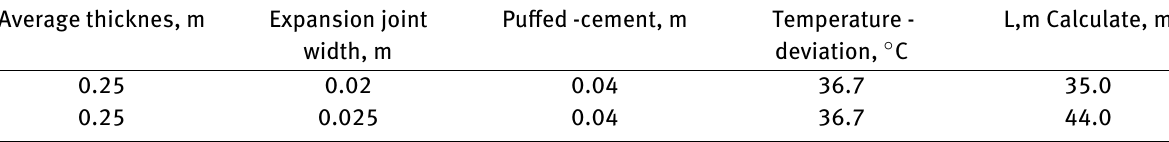
Table 3: Intervals between expansion joints for airdrome pavement Average thicknes, m Expansion joint Puffed - cement, width, m